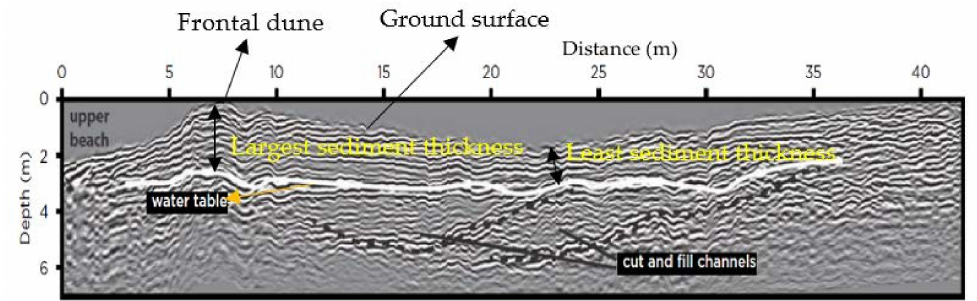
Figure 8. The topographically corrected processed form of field GPR data collected from the Old Bar Beach, New South Wales, Australia, by previous researchers [25]. Different hydrogeological features have been marked on it by